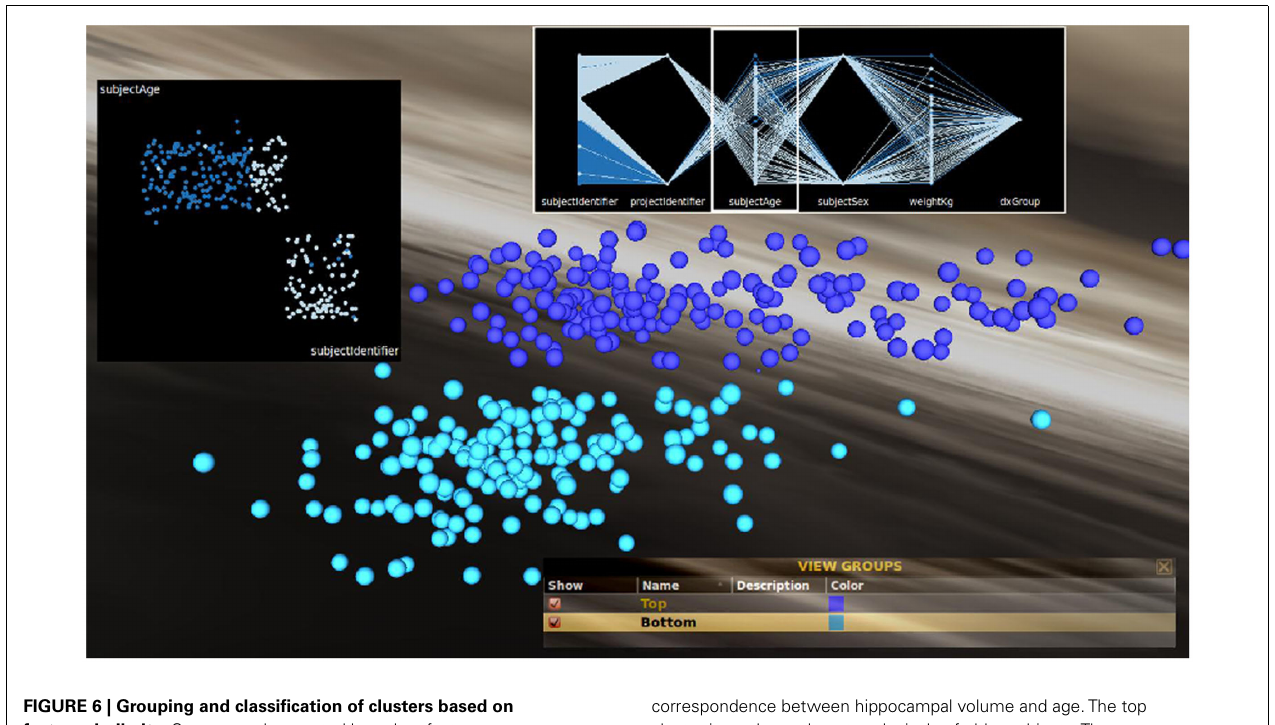
FIGURE 6 | Grouping and classification of clusters based on feature similarity. Groups can be created based on feature similarity and then linked scatter (left inset) and parallel coordinates plots (upper insert) can be created within INVIZIAN to help to illustrate that, in this instance, there is a relationship of